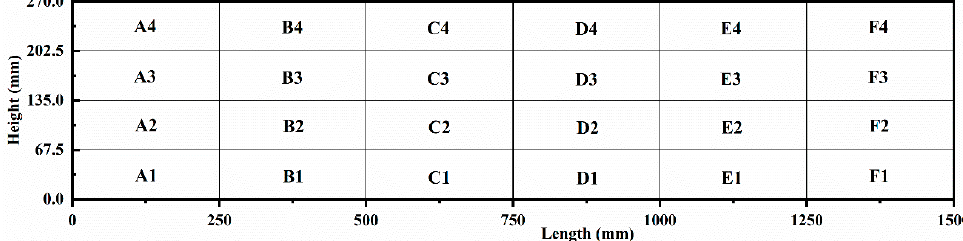
Figure 3. The region codes of the channel for particle size analysis.